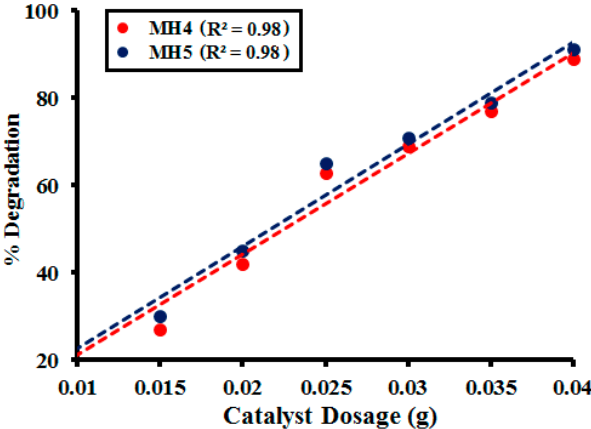
Figure 6. Photocatalytic degradation of alizarin red (AR) dye (250 ppm) at different catalyst doses of MH4 and MH5 after 60 min of photocatalytic activity.